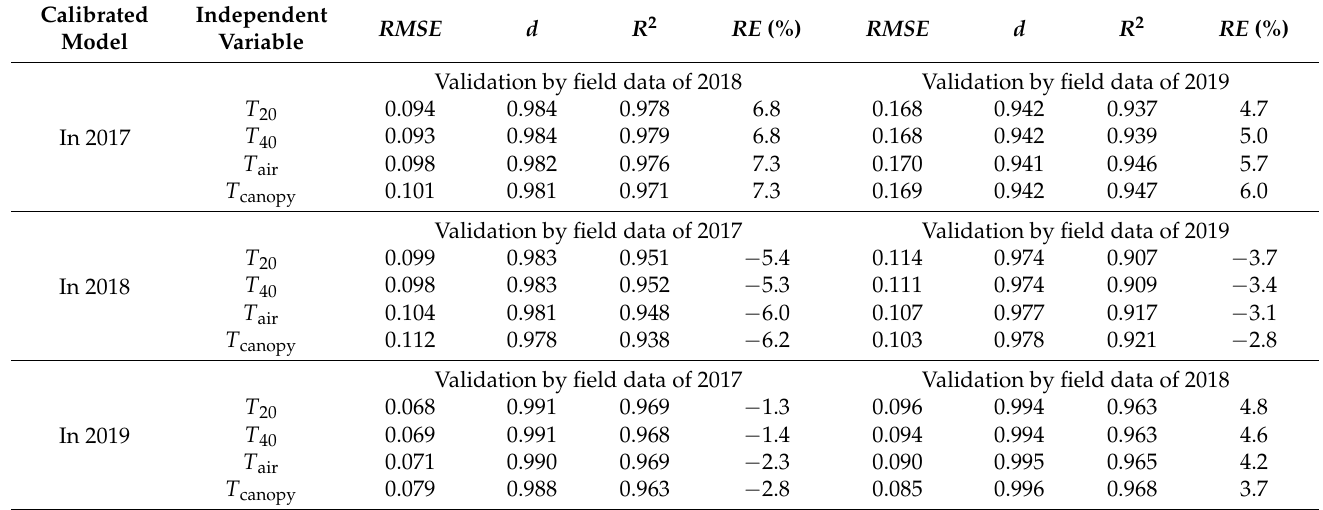
Table 2. Validation results of the N-logistic model of RDBA with T 20 , T 40 , T air , and T canopy between the simulated and observed data from five plots in 2017–2019.